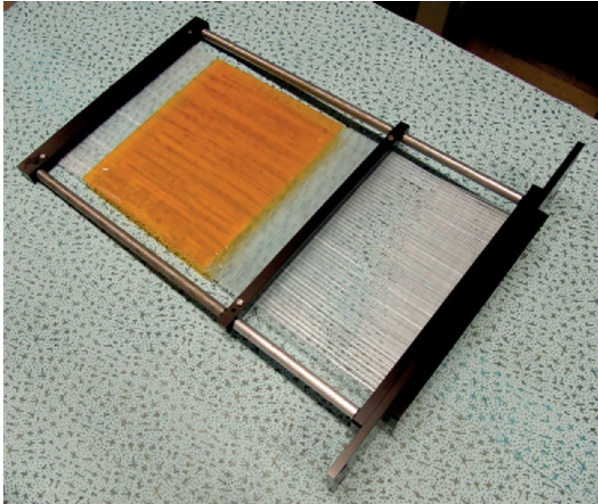
FIG. 11. XBPF module, used as beam profile monitors. The fibers are read out by 192 SiPMs coupled with CITIROC ASICs, that transfer thesignaltotheback-endVFC asdiscussedinthetext.